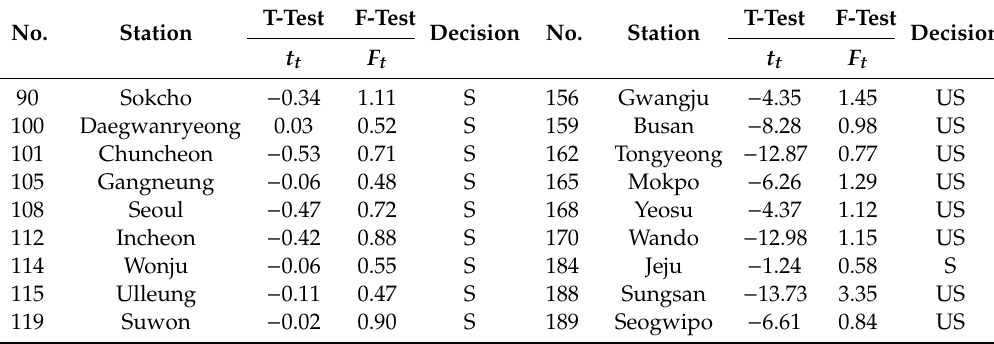
Table 4. Simple T-test and F-test analysis of annual precipitation